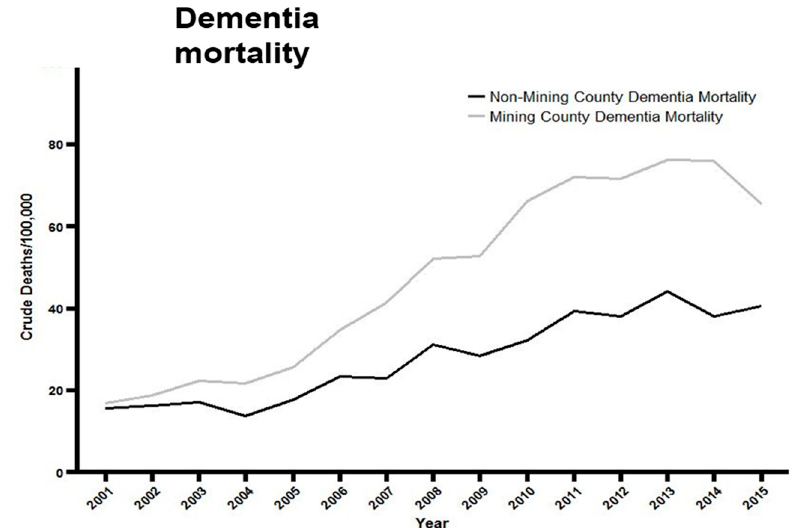
Figure 5. A negative binomial regression with a log link function was used to compare the relative